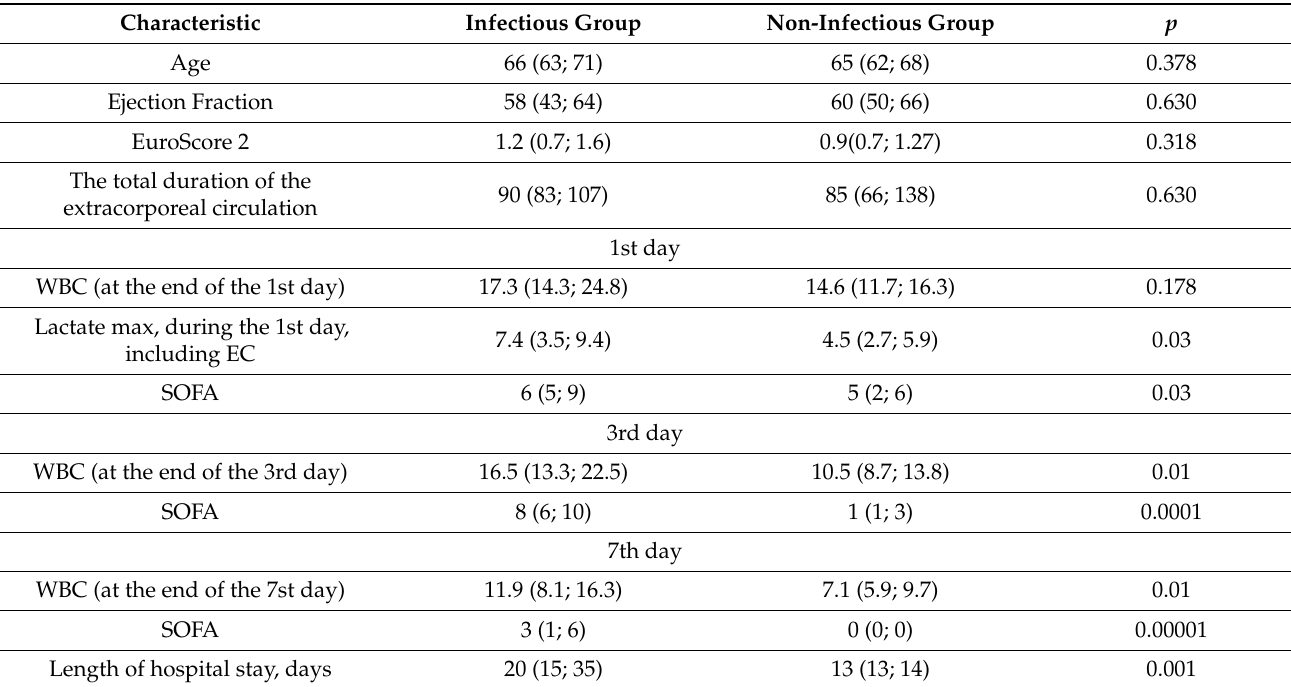
Table 1. Patients’ baseline